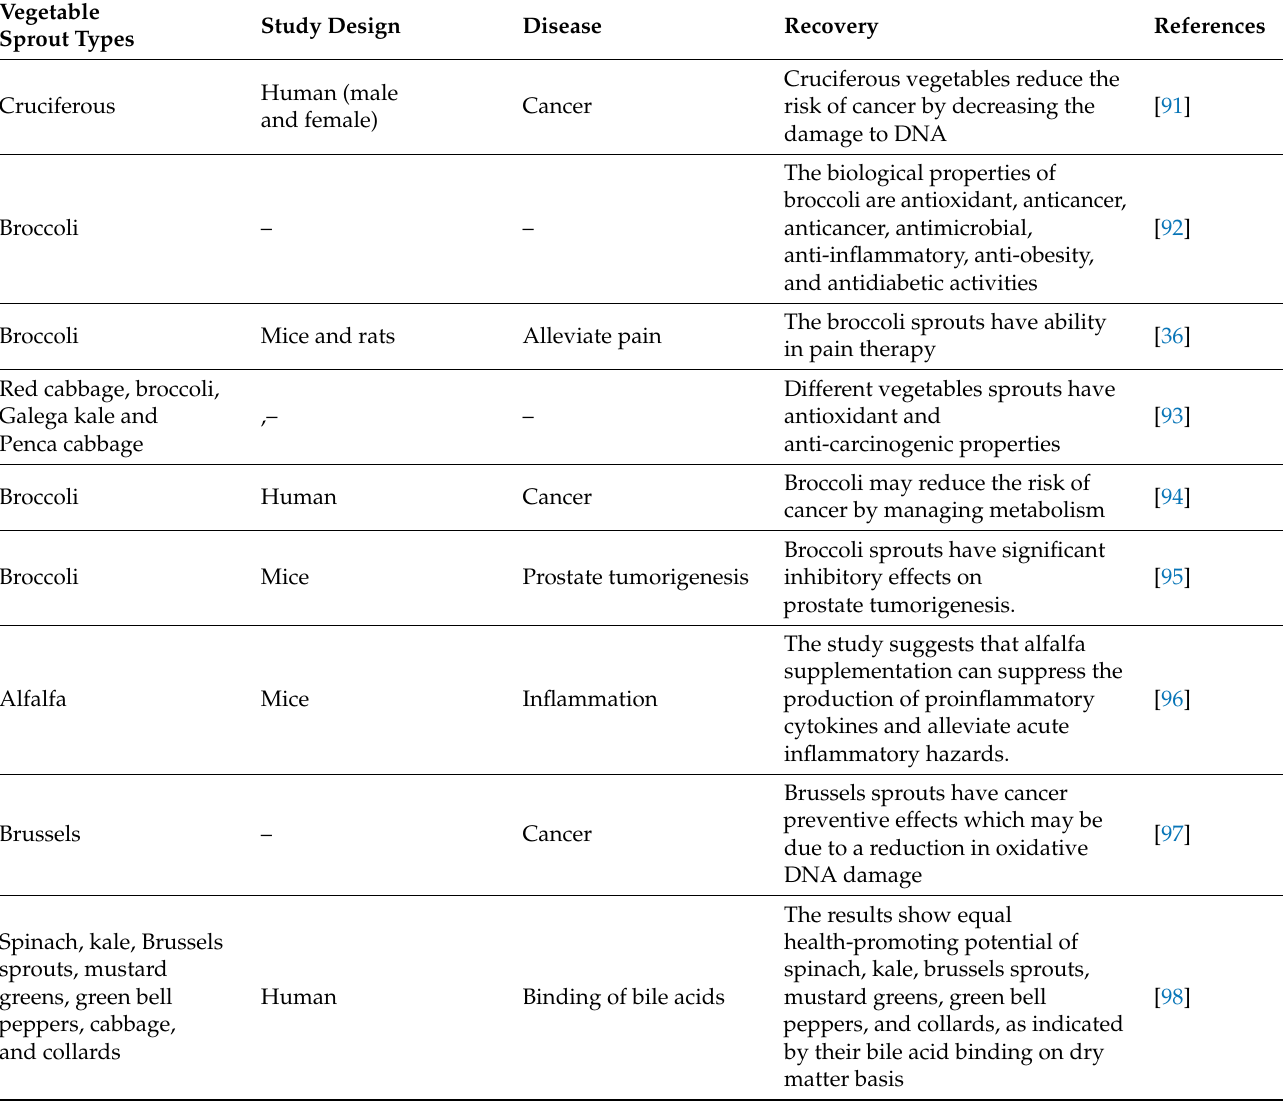
Table 3. Bioavailability of sprouts against different